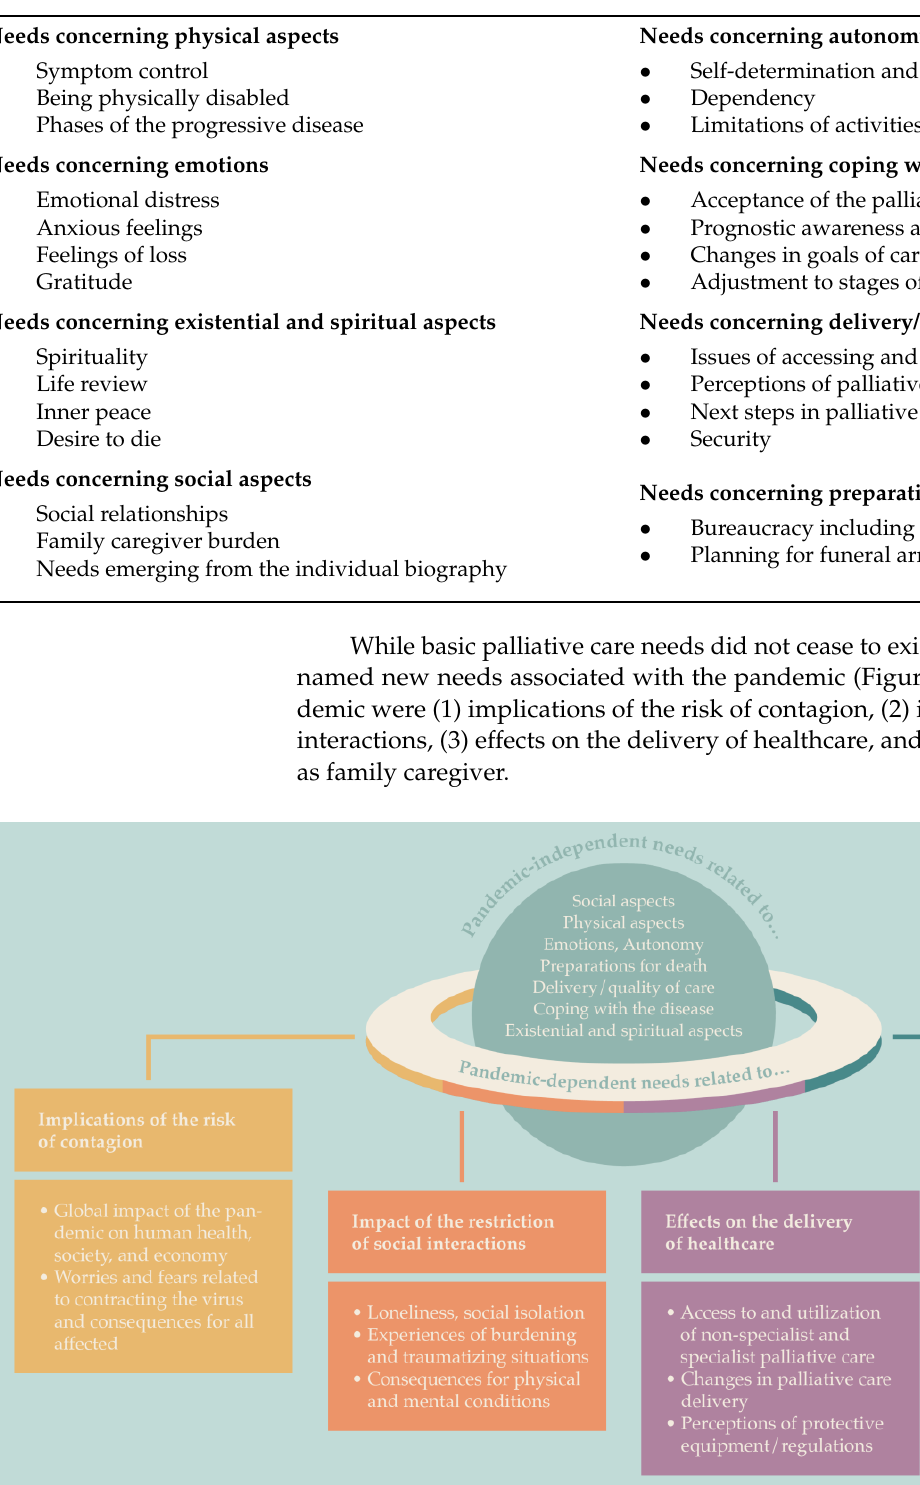
Patients and family caregivers described a variety of ways in which possible SARS- CoV-2 infection affected them. Most patients reported not to care about being infected by